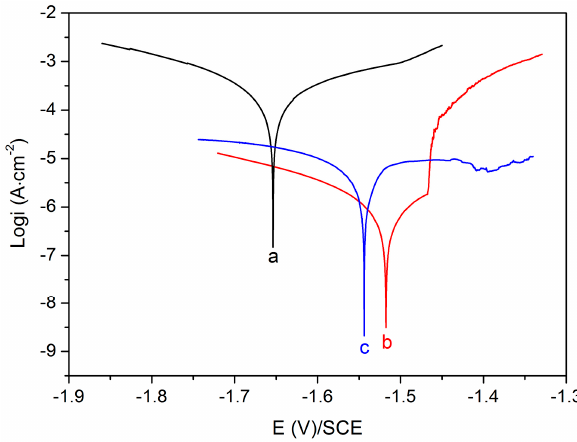
Figure 4. Tafel polarization curve of ( a ) uncoated Mg alloy; ( b ) MgF 2 -coated Mg alloy; and ( c ) Mg-MOF-74/MgF 2 -coated Mg alloy in SBF. Table 1. Results of Tafel polarization tests in SBF